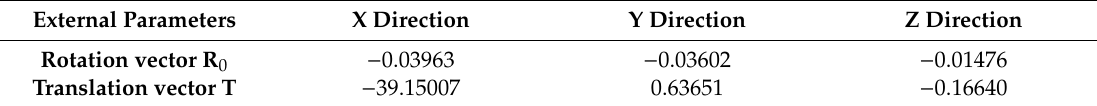
Table 1. Internal parameters and errors of binocular camera.